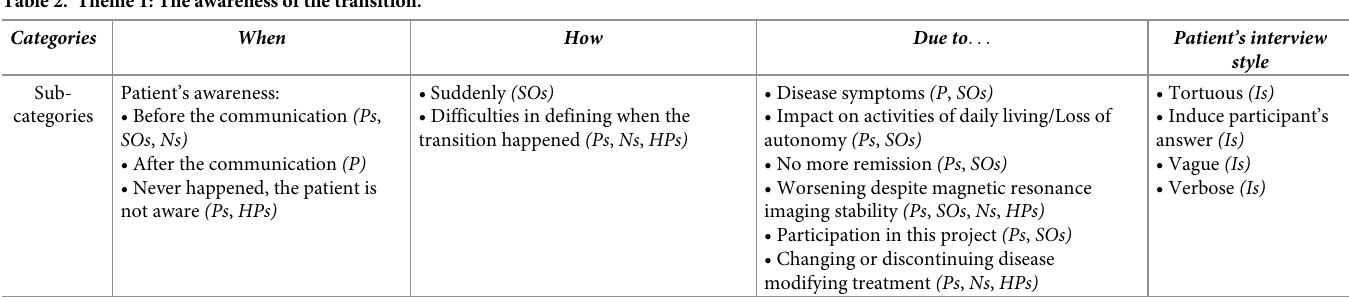
Table 2. Theme 1: The awareness of the transition.